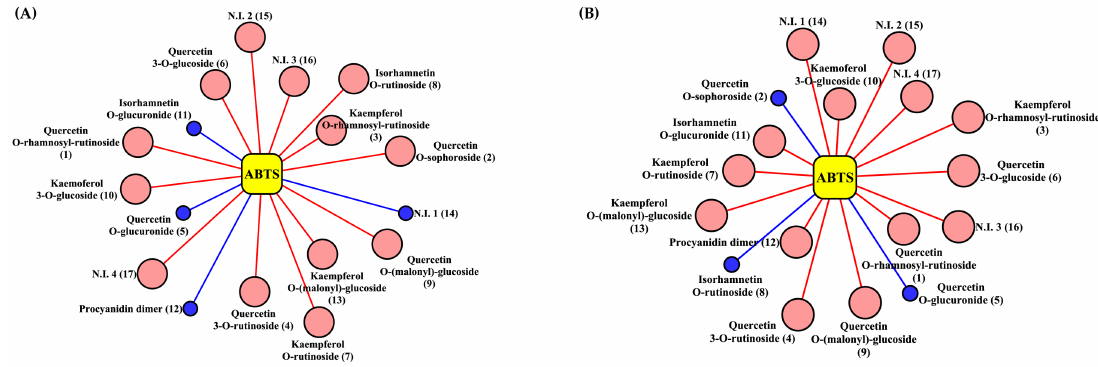
Figure 4. Visualization of the correlation networks between the identified secondary metabolites and ABTS radical scavenging activity assay of A. aspera ( A ) and Z. serrata ( B ) according to Pearson (cid:48) s correlation coefficient. Correlation coefficients higher than 0.80 or lower than − 0.80 with p -value < 0.05 are extracted and shown in these association networks. Each node indicates an identified metabolite and corresponding ABTS assay. Yellow node = antioxidant activity assay, Pink node = positively correlated metabolite, Blue node = negatively correlated metabolite. The sizes of the nodes represent the degrees of association. The numbers on the metabolites are those indicated in Table